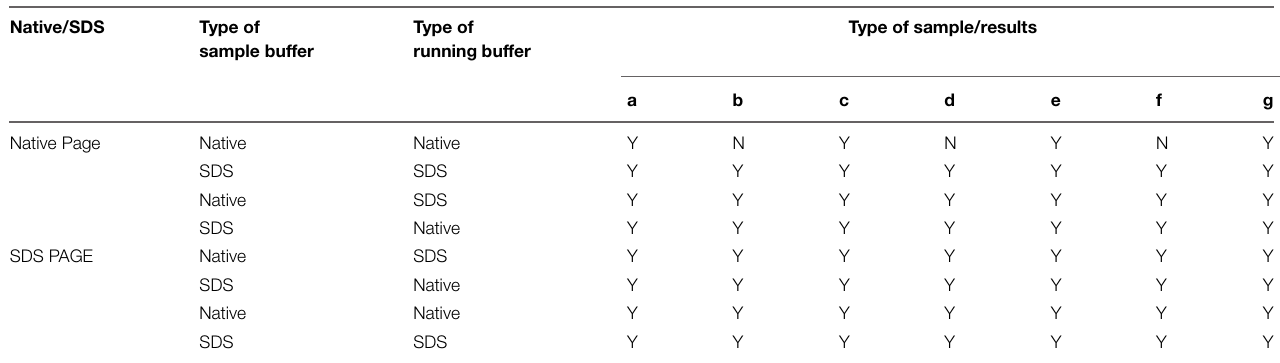
TABLE 2 | Formation of non-specific ZOI with different sample types in native and SDS-PAGE.